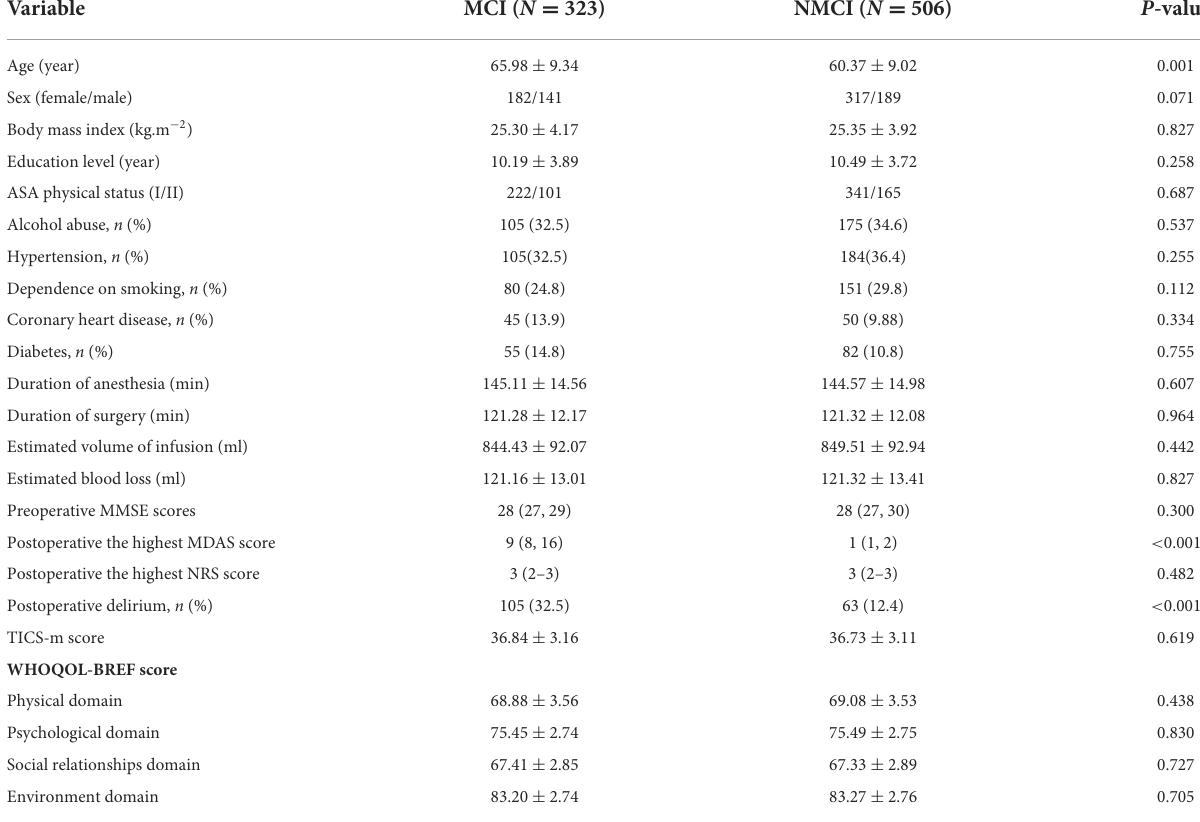
TABLE 1 Comparison of demographic and clinical data of unilateral total knee arthroplasty patients.